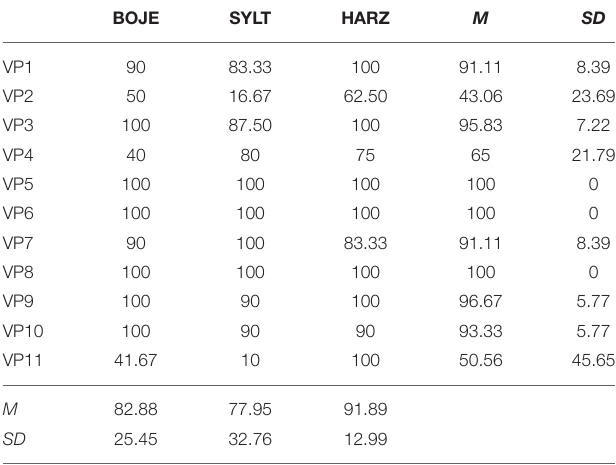
TABLE 2 | Online spelling accuracies in the auditory